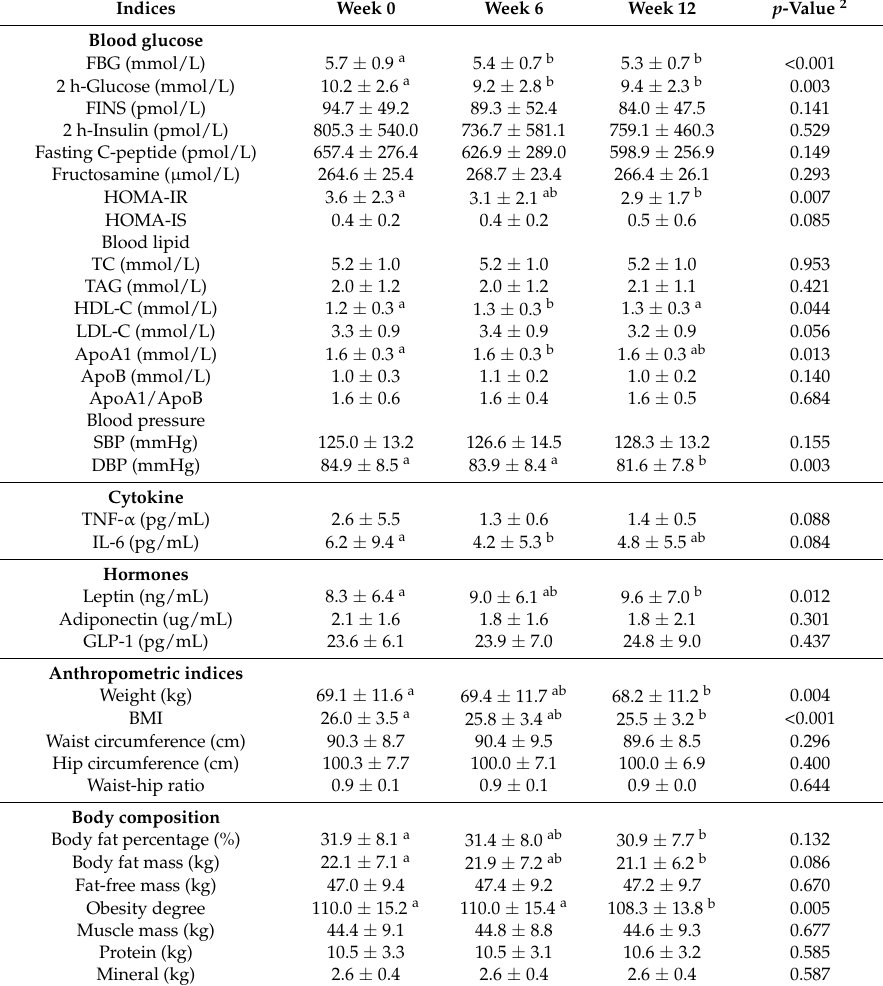
Table 1. T Metabolic characteristics of subjects during study period 1